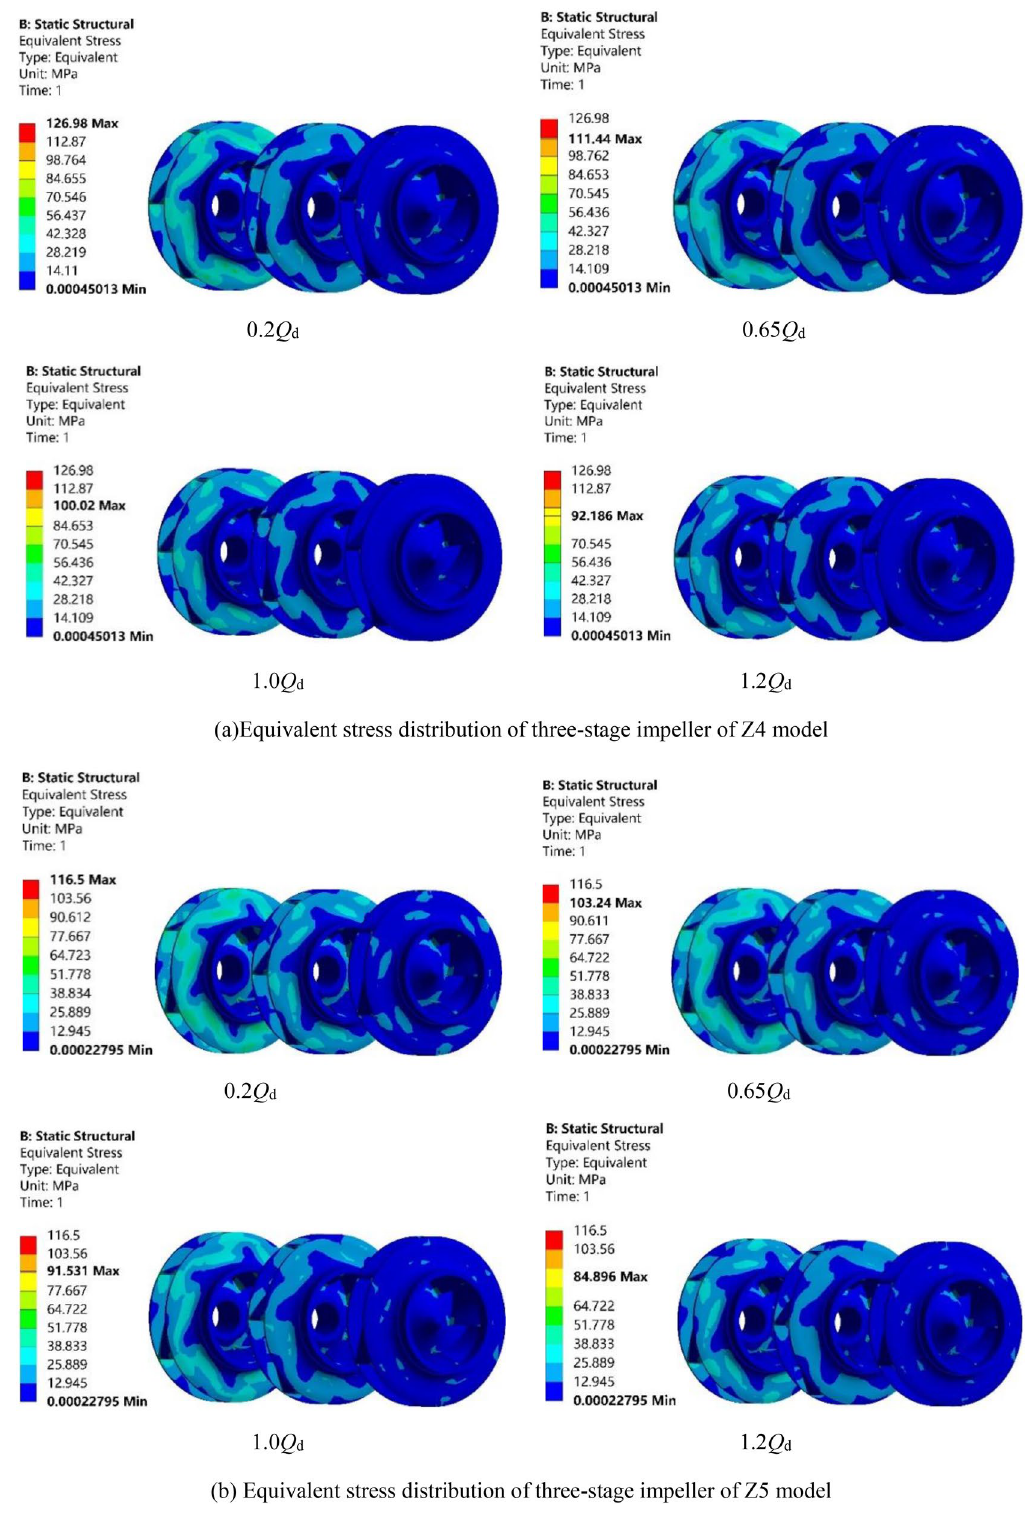
Figure 12. Equivalent stress distribution of the three models under four working